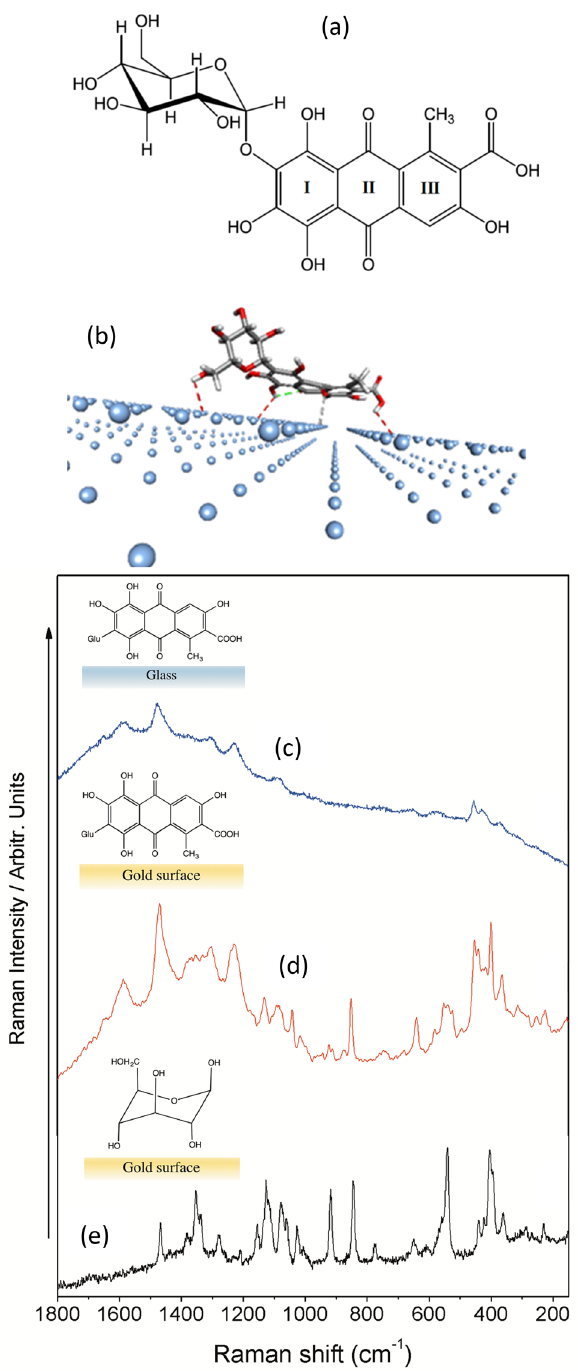
Figure 1. Structure of carminic acid ( a ) and scheme of the interaction of carminic acid with an Ag surface ( b ). Raman spectra of carminic acid on glass ( c ) and on a Au surface ( d ). Raman spectrum of glucose on Au surface ( e